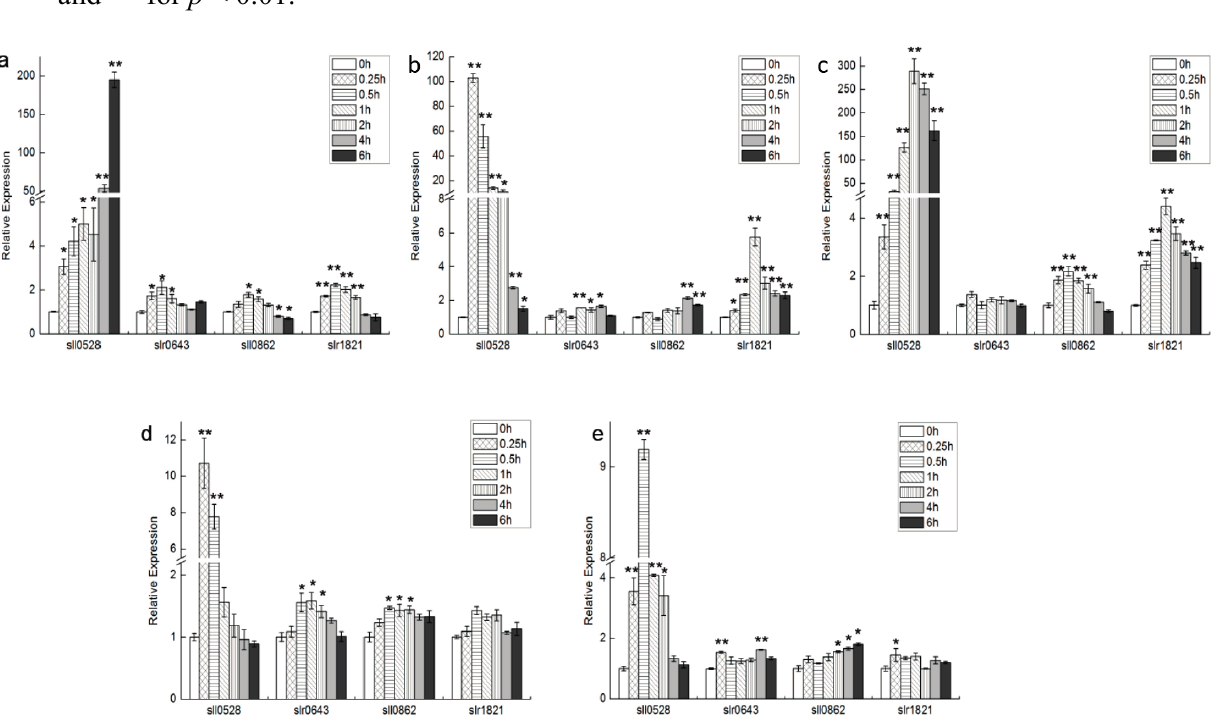
Figure 1. Transcriptional profiles of four S2P homologs under different conditions.